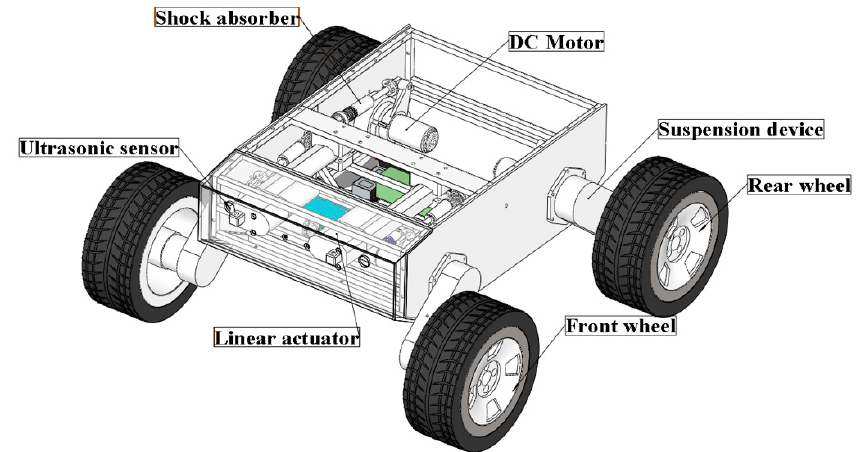
Figure 1. Structure of deformable wheel-legged hybrid robot (WLHR).